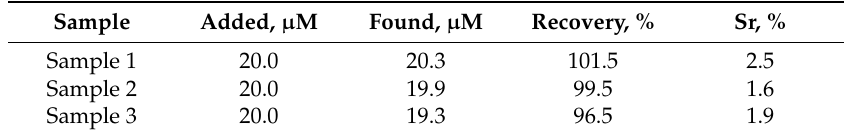
Table 5. Analysis results of milk samples using 2.5% Nf/Au(5 nm)/CSPE ( n = 3, p = 0.95).